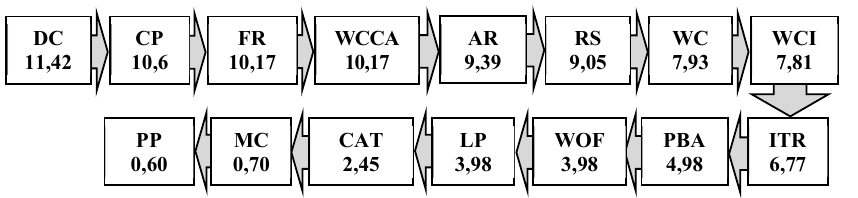
Fig. 5. Ranking of indicators by their importance in the